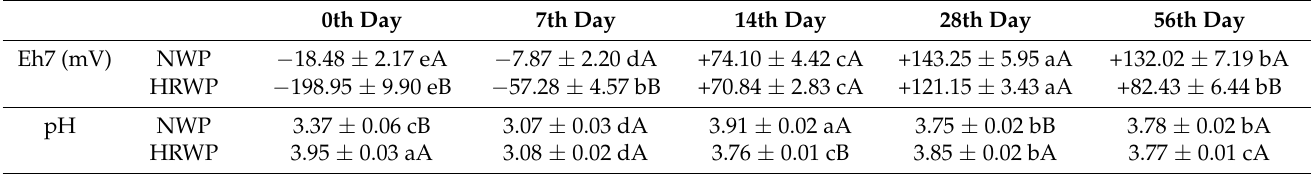
Table 1. Changes in Eh7 (mV) and pH in beet (Beta vulgaris) pickles during fermentation stages (days).